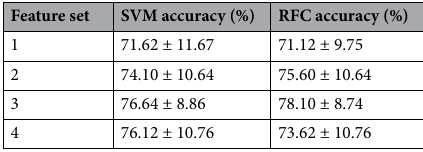
Table 1. Accuracy and standard deviation (%) for binary classification using SVM and RFC on four different sets of features.